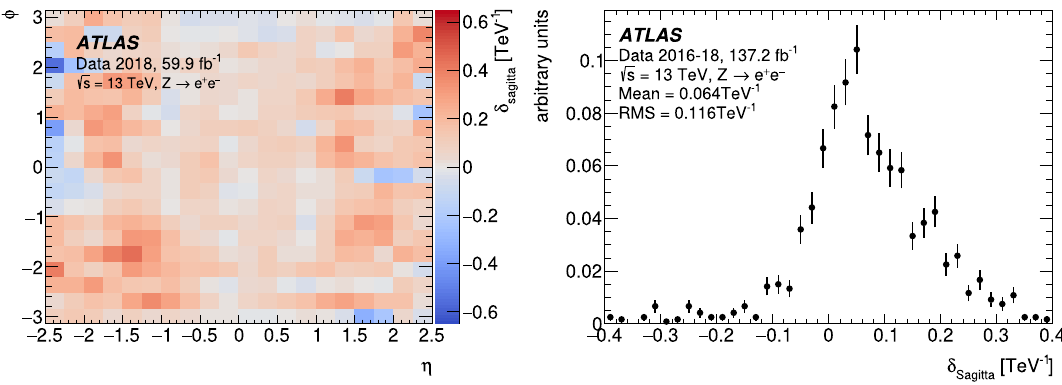
Fig. 20 Sagitta biases versus η and φ (left) for 2018 data and the overall sagitta biases of the Run 2 data (right) for the E / p method. The error bars represent the statistical uncertainty